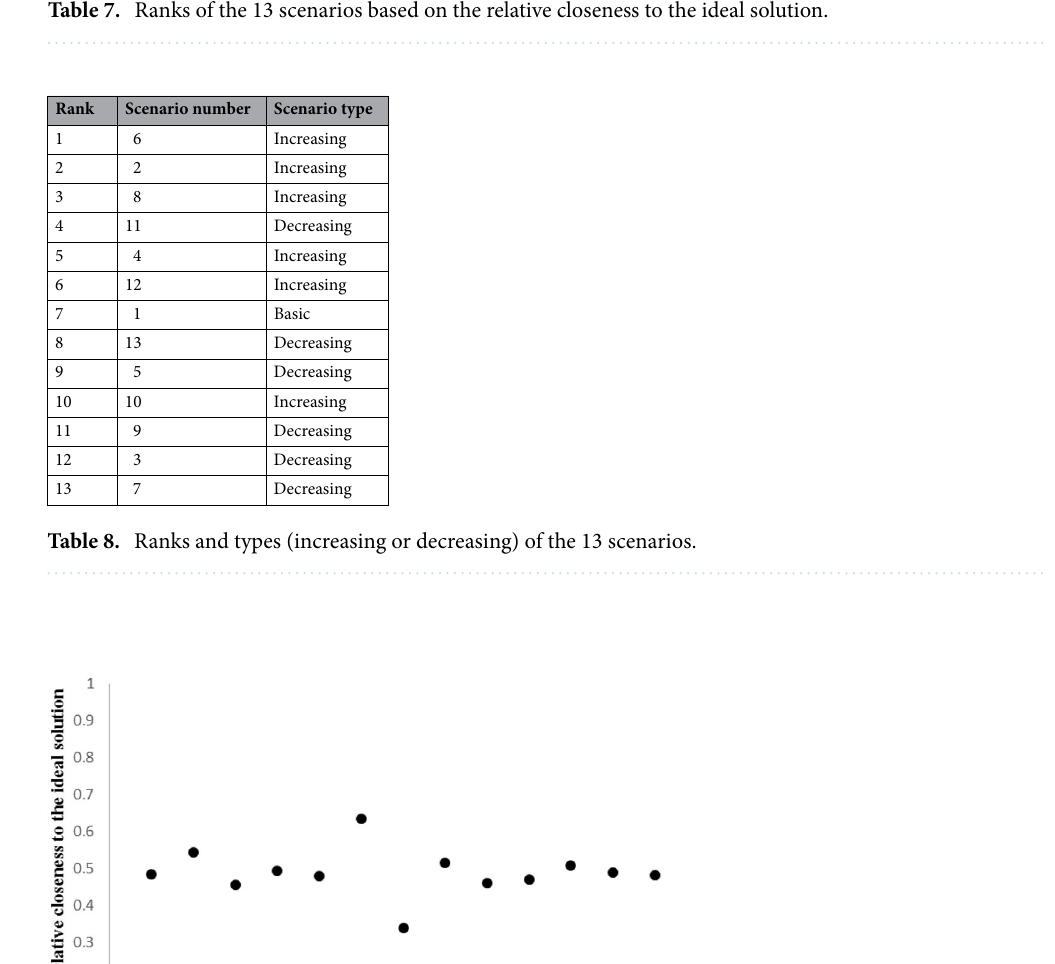
Table 7. Ranks of the 13 scenarios based on the relative closeness to the ideal